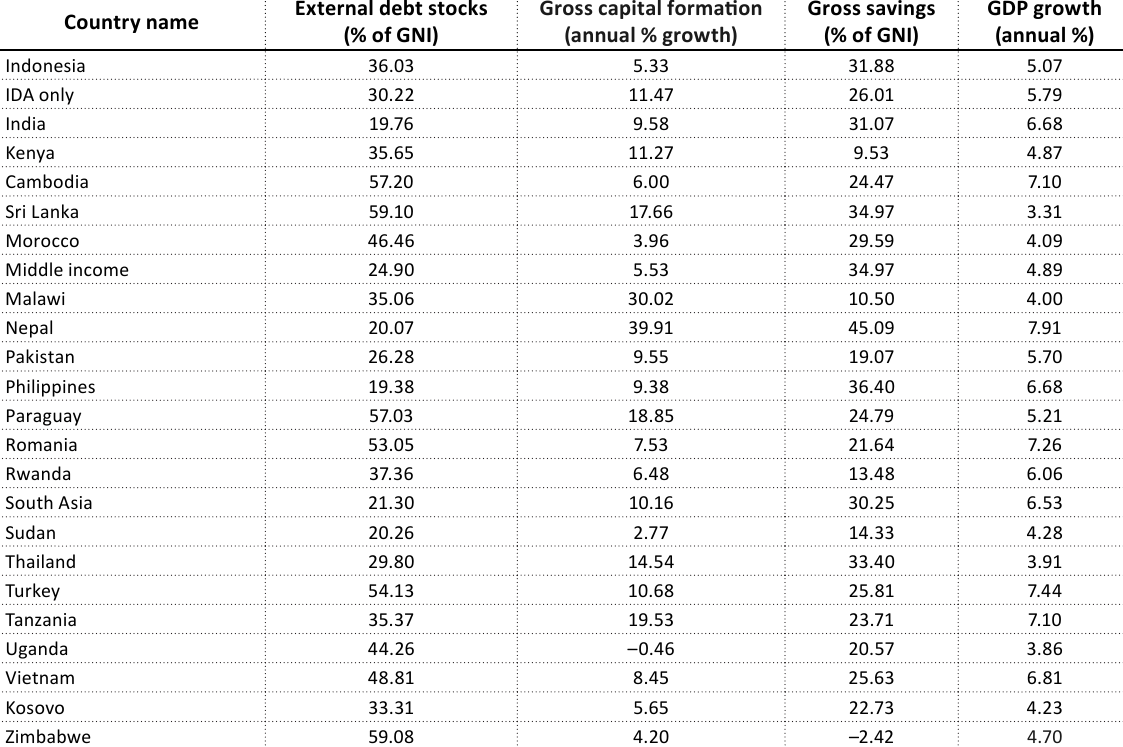
Table H1 (cont.). Grouping of countries by level of economic